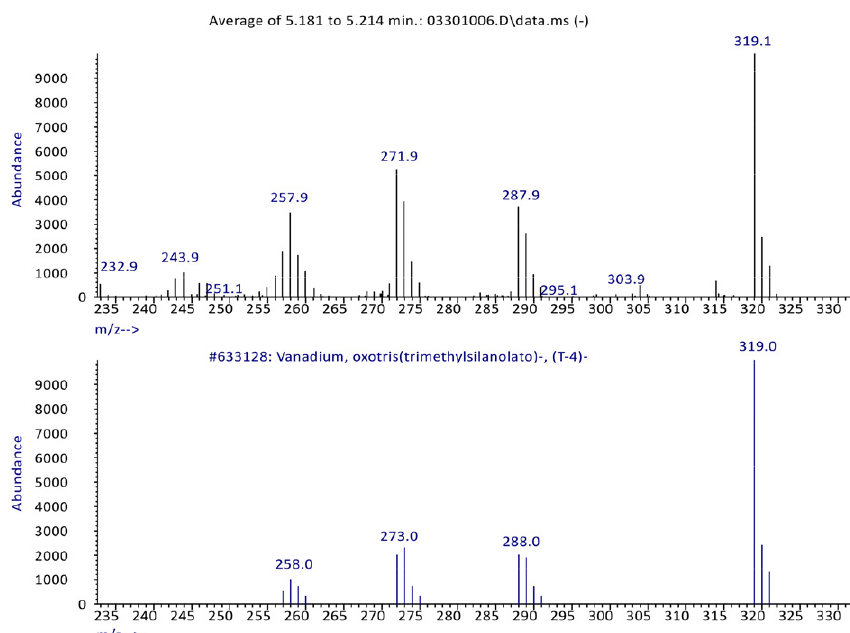
Figure 5. Mass spectrum comparison of vanadic(V) acid 3TMS derivative in sample 03 and Willey-NIST library mass spectral data.